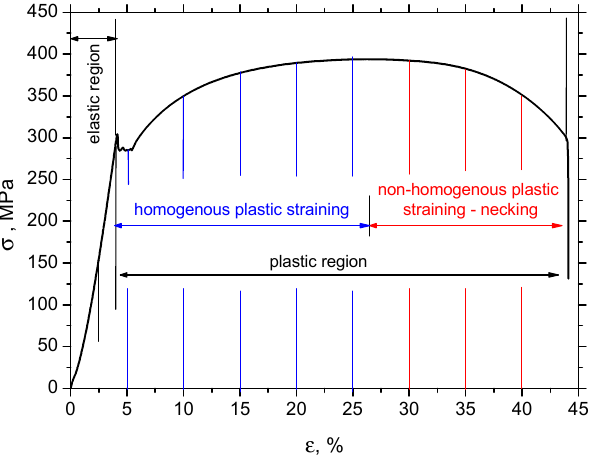
Figure 2. Stress–strain (engineering) curve of S235 steel, deformation speed 1 mm · min − 1 (strain rate 0.33 × 10 − 3 ).